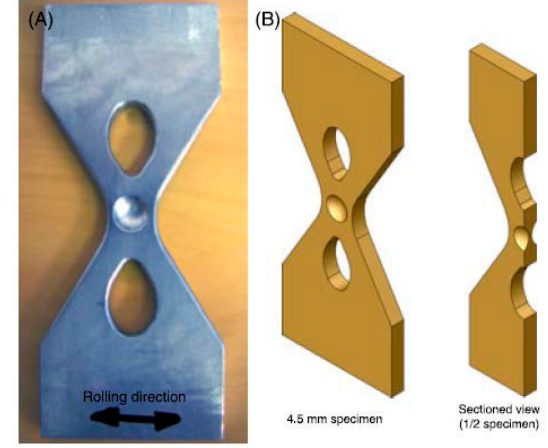
Figure 13. The ‘Twin-Teardrop’ specimen [87].